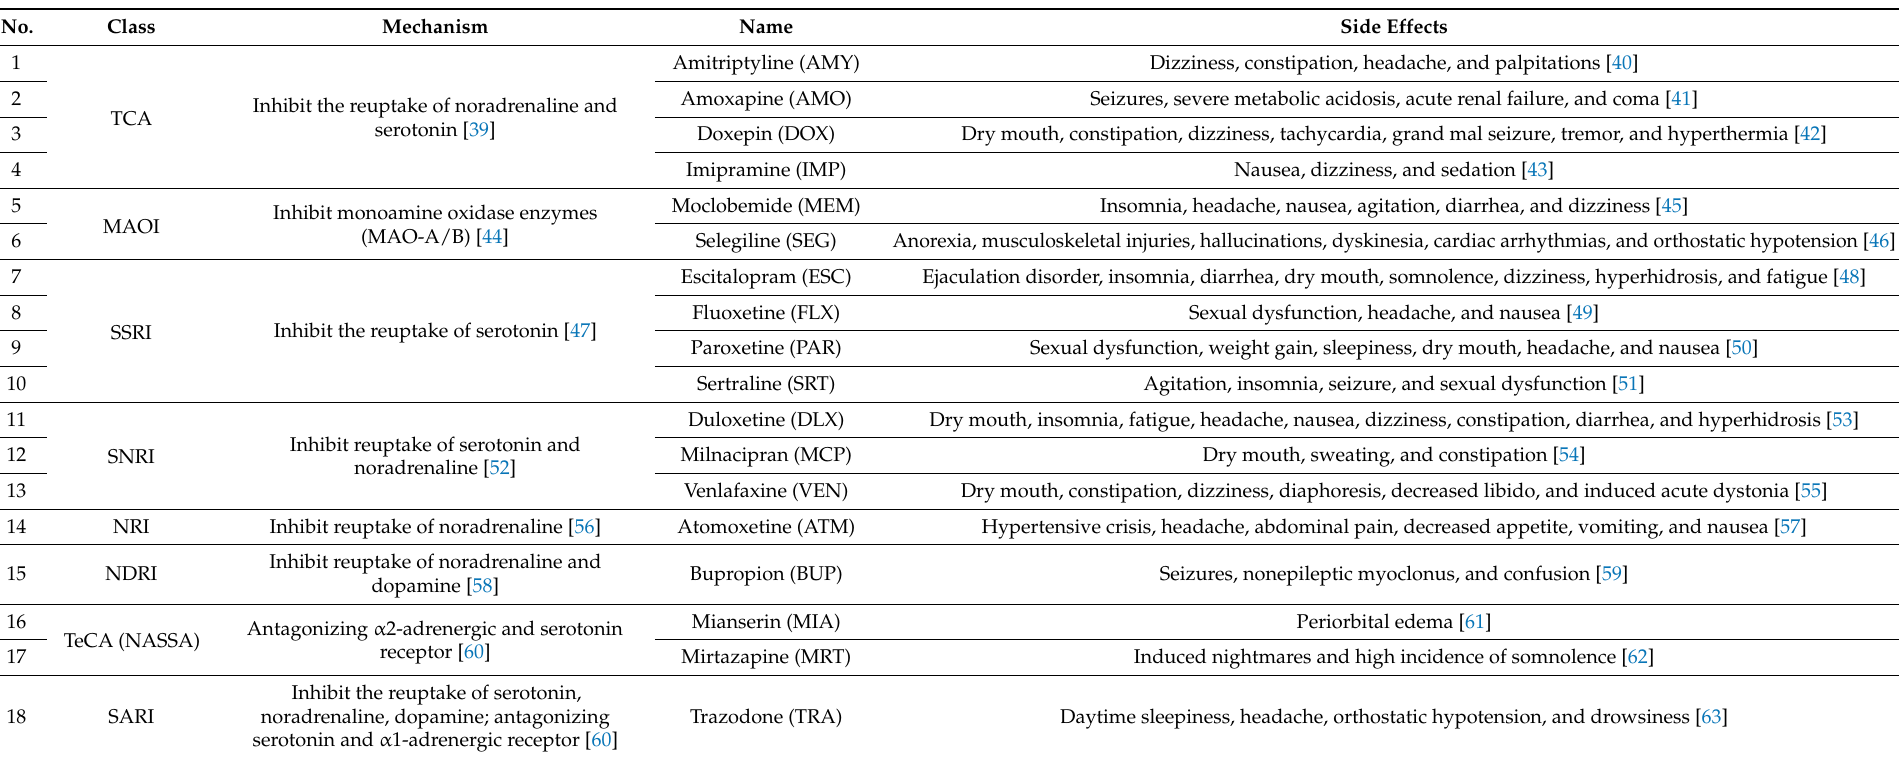
Table 1. List of antidepressants used in this